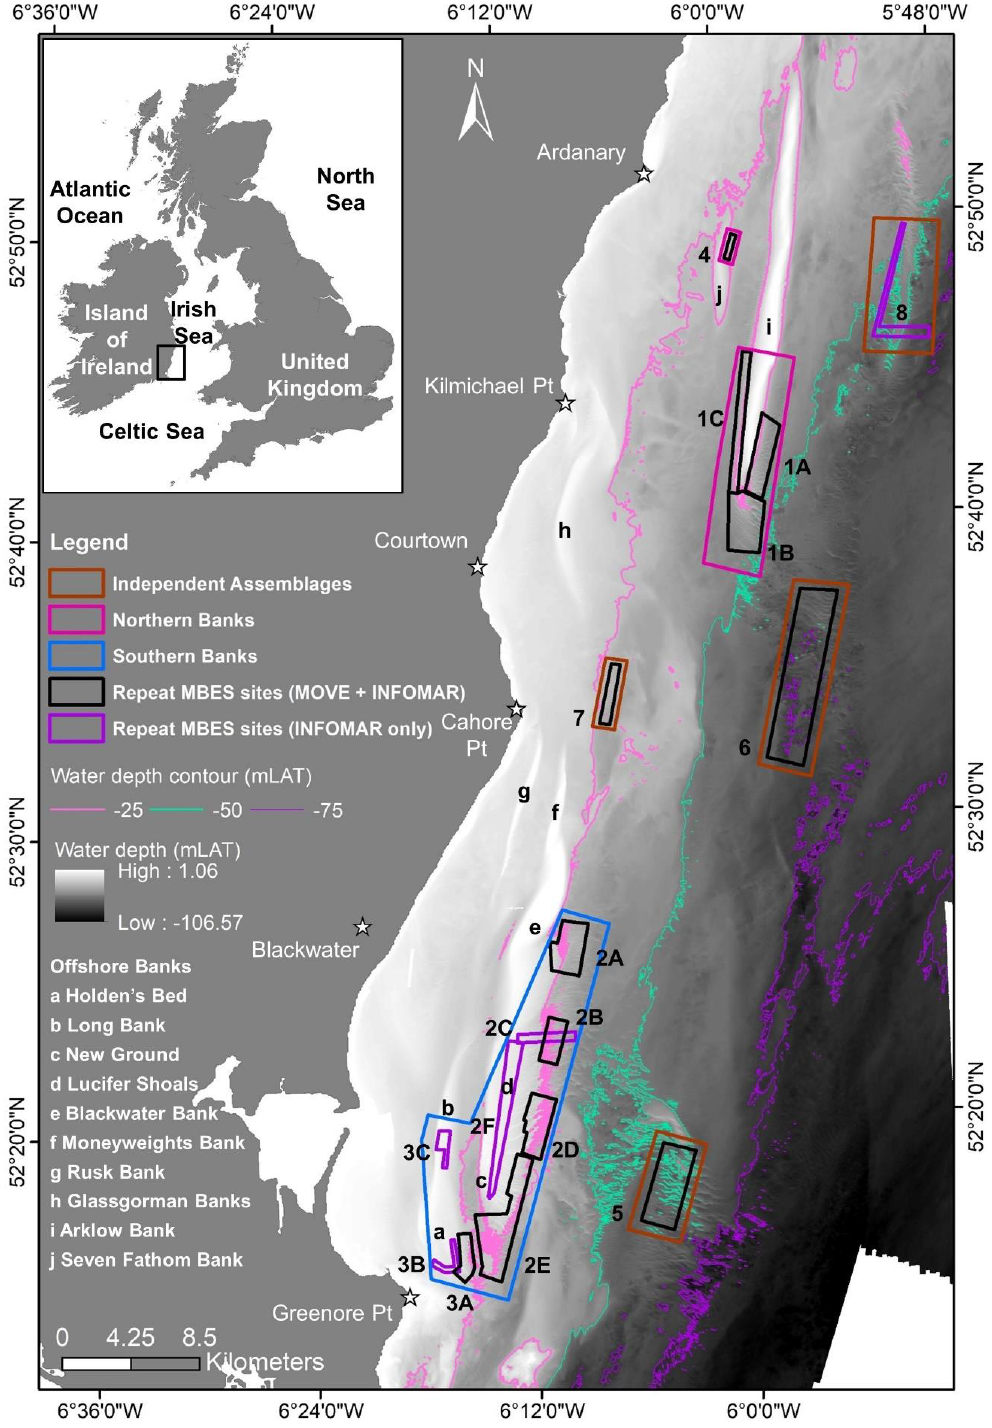
Figure 2. Location of multi-beam echo sounder (MBES) bathymetry datasets analysed in this study. Available datasets at each site are presented in Table 2. Sites are grouped into three environments for sediment wave analysis: Independent Assemblages, Northern Banks and Southern Banks, which are indicated by blue, pink, and green polygons respectively. Bathymetry source: composite map produced from INFOMAR datasets (https://www.infomar.ie/data [Accessed: 10 June 2021]) (see Section 3.1).